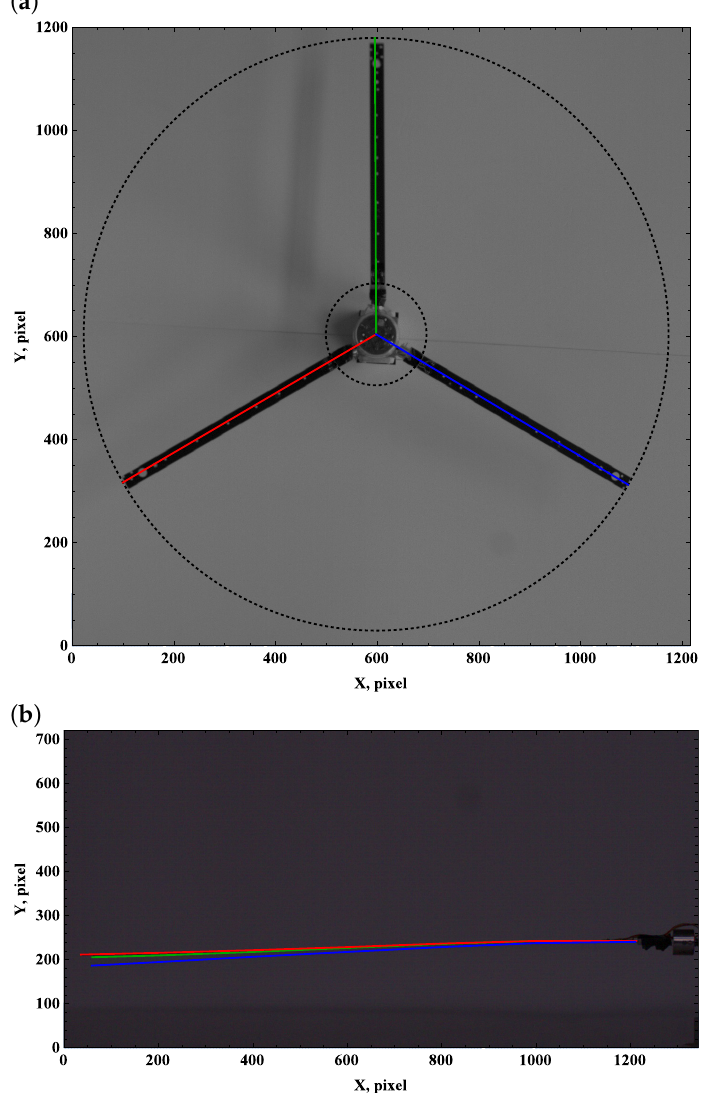
Figure 3. Preset angle 0 ◦ , angular speed 50 rpm: top view ( a ), side view ( b ). We introduce colors green, red, and blue to construct lines for beams A, B, and C, respectively. Considering the top view frames, straight lines originate from the hub axis 0 1 = ( X 0 , Y 0 ) and reflect the longitudinal axis of the undeformed beam. Line segments are described by origin 0 1 and tip points defined at a distance R 2 from the origin